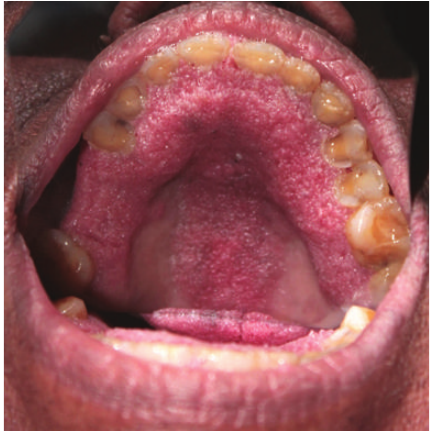
Figure 4: Extensive lesion seen involving